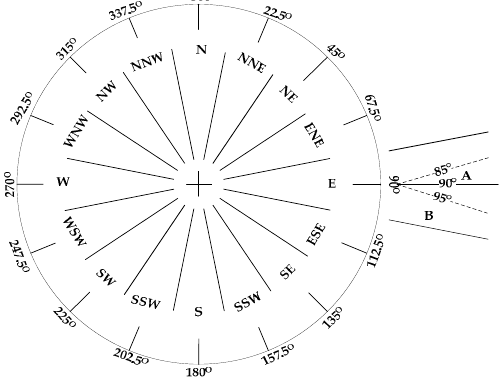
Figure 3. Sixteen wind direction map.